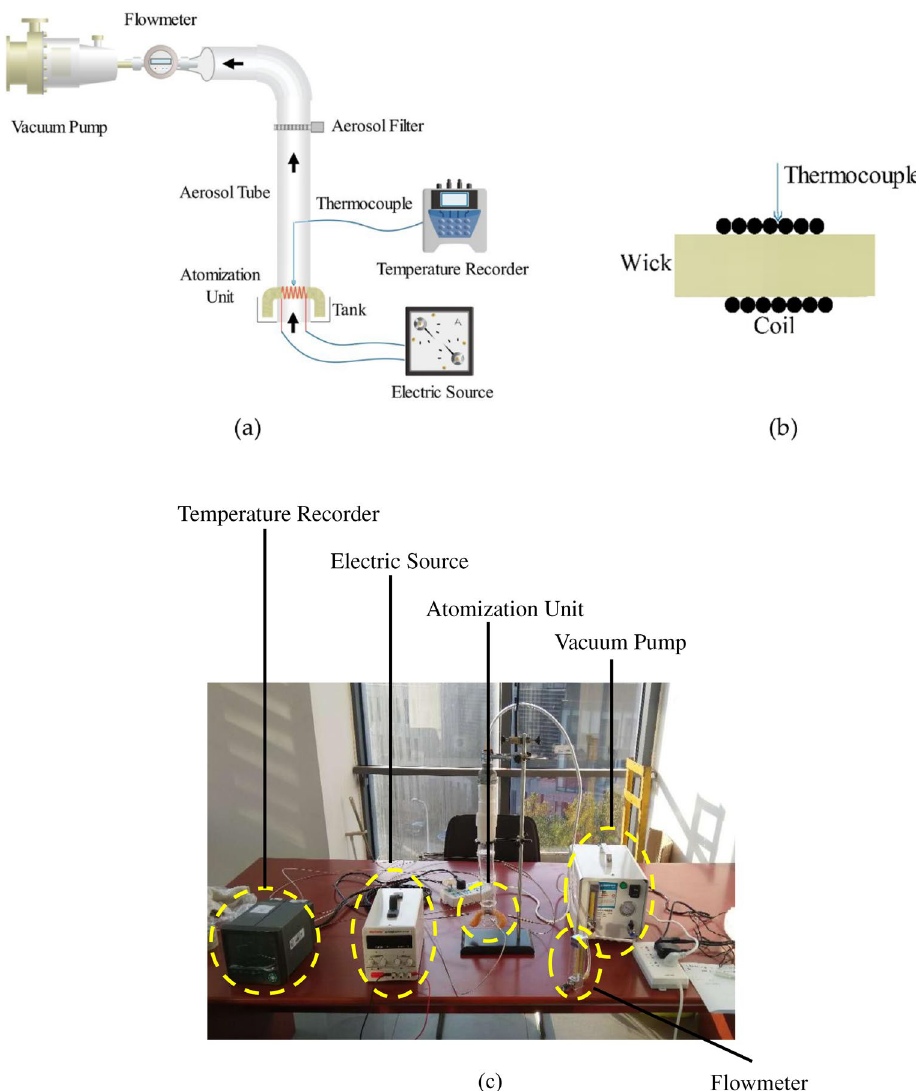
Figure 7. ( a ) Schematic diagram of experimental platform; ( b ) Detail view of coil and wick; ( c ) Physical picture of experimental platform (Note: The diameter and length of the prototype wick are 3 mm and 16 mm, respectively. The wick is made of cotton. The porosity of the wick is 0.44. The coil is wound on the outer surface of cylindrical wick. The measuring point of thermocouple is contacted with the coil. The diameter of the prototype aerosol tube is 8